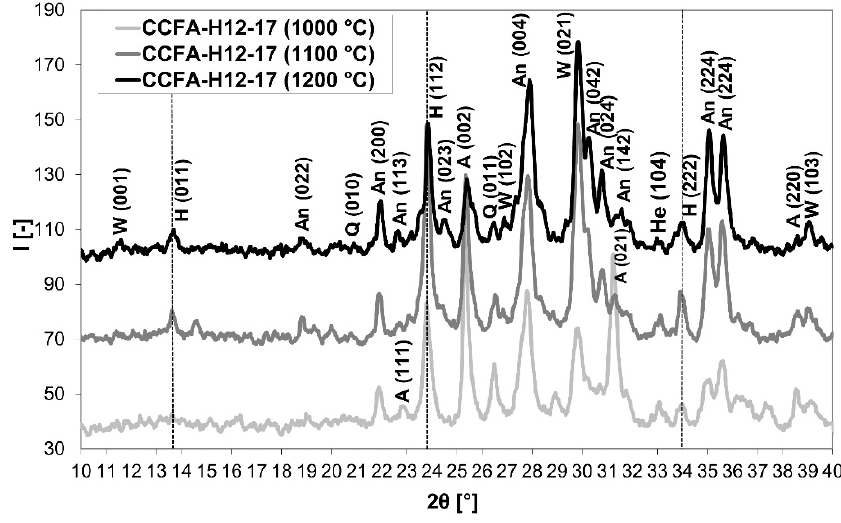
Figure 5. The effect of the firing temperature on the mineralogical composition of the CCFA-H12-17 body (W: Wollastonite, H: Haüyne, An: Anorthite, A: Anhydrite, Q: Quartz, He: Hematite).